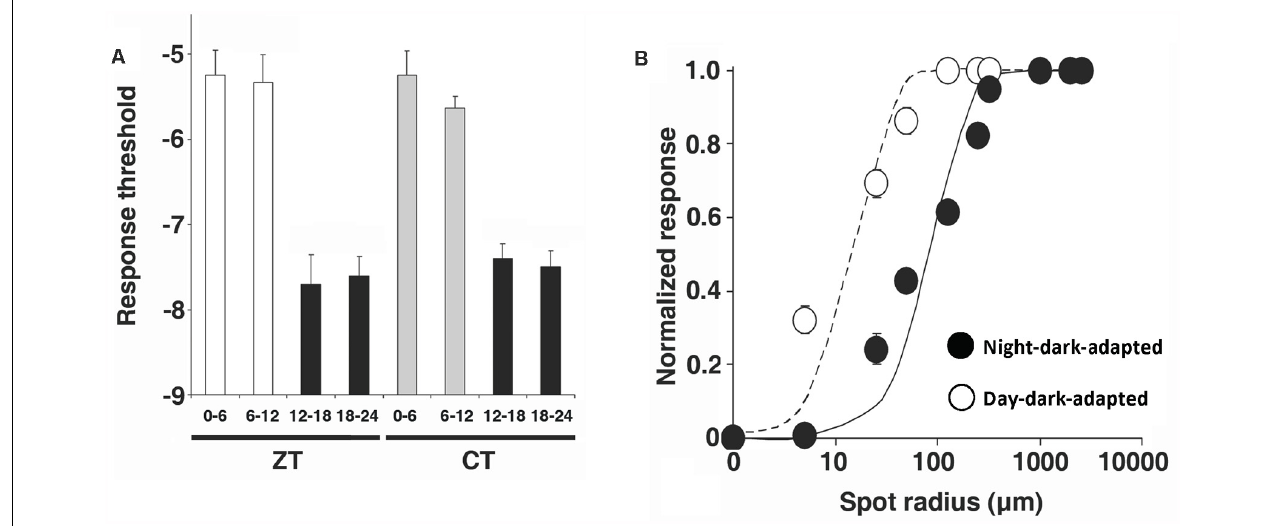
FIGURE 13 | Retinal circadian clock increases receptive field size and sensitivity of cones to dim light by enhancing rod-cone coupling at night. (A) Under dark-adapted conditions, the average cone light response threshold (log intensity required to elicit a 0.5 mV response) was significantly higher during the day and subjective day than during the night and subjective night. (B) Average normalized response amplitudes of dark-adapted cones plotted against stimulus radius for a stimulus of intensity -5 log I o , indicates that the receptive field size of cones is larger at night (filled circles) than in the day (open circles). Error bars indicate SEM. Modified from Ribelayga et al. (2008).